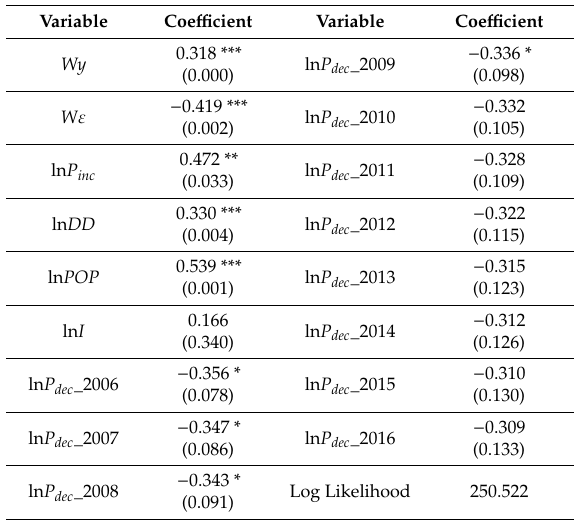
Table 5. Estimation results of SARAR fixed-e ff ect model with partial variable coe ffi cients.